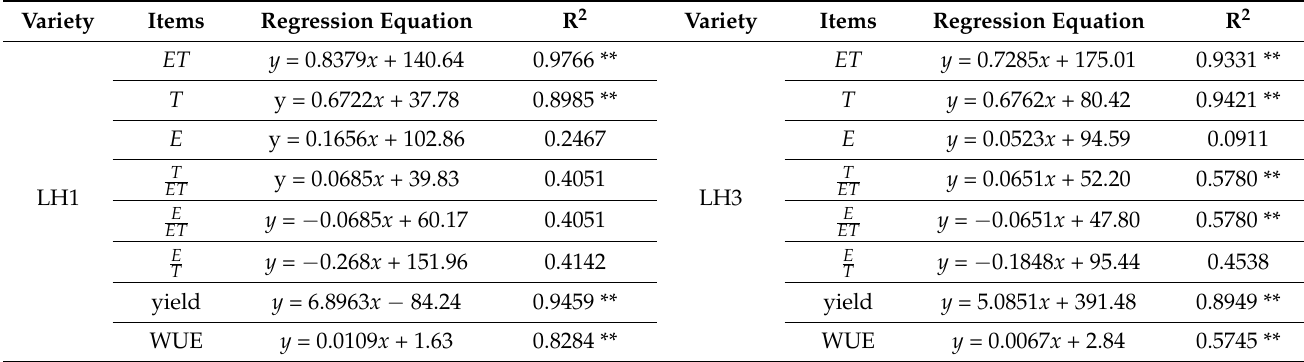
, T , yield and ET ET , T , E , yield and ET ET T , (cid:3021) , (cid:3006) , y ield and (cid:3006)(cid:3021) (cid:3006)(cid:3021) (cid:3021)